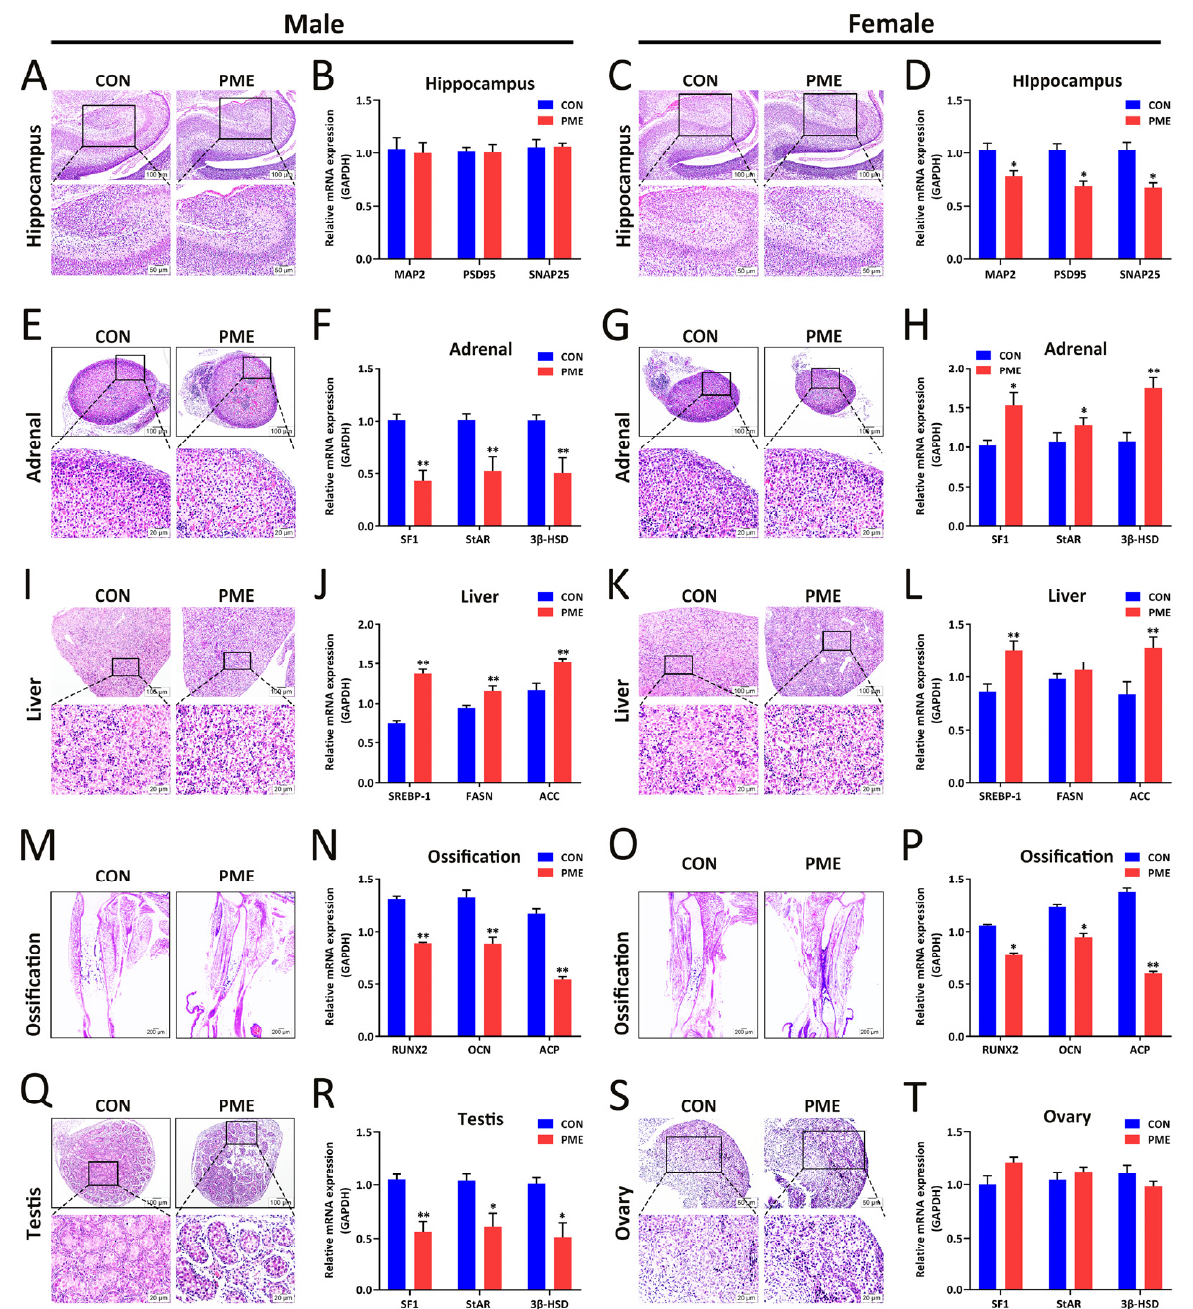
Figure 6. Paternal mixed exposure (PME) to nicotine/ethanol/caffeine induces multiple organ dysfunction in offspring. ( A , C ) H&E staining of the hippocampus in male and female fetuses. ( B , D ) mRNA expression of MAP2, PSD95, and SNAP25 in male and female fetal hippocampi. ( E , G ) H&E staining of the adrenals in male and female fetuses. ( F , H ) mRNA expression of SF1, StAR, and 3 β -HSD in male and female fetal adrenals. ( I , K ) H&E staining of the livers in male and female fetuses. ( J , L ) mRNA expression of SREBP-1, FASN, and ACC in male and female fetal livers. ( M , O ) H&E staining of the ossifications in male and female fetuses. ( N , P ) mRNA expression of RUNX2, DCN, and ACP in male and female fetal ossifications. ( Q , S ) H&E staining of the testis ( Q ) and ovary ( S ) in fetuses. ( R , T ) mRNA expression of SF1, StAR, and 3 β -HSD in fetal testis ( R ) and ovaries ( T ). Means ± S.E.M, n = 10, * p < 0.05, ** p < 0.01 vs. CON (control).